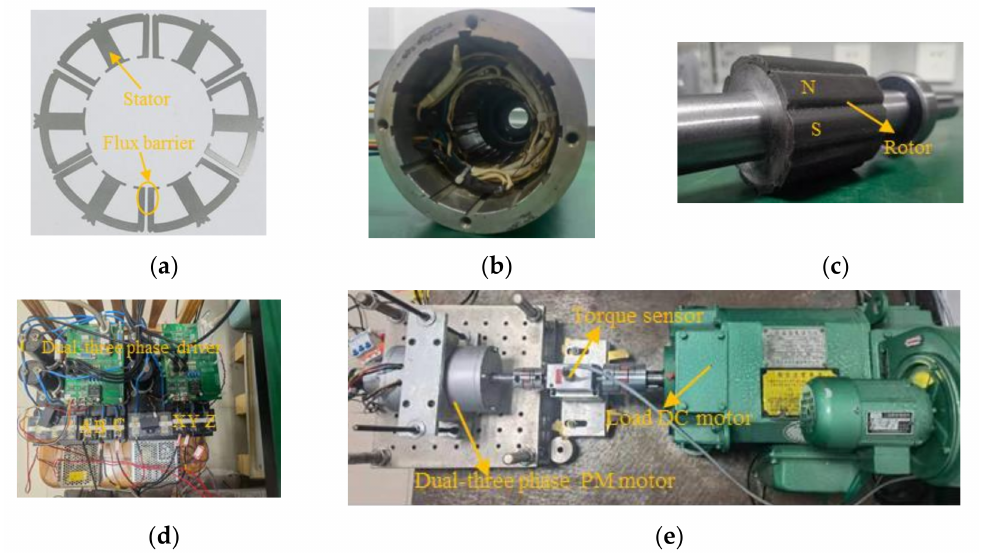
Figure 16. Machine prototype and test rig. ( a ) Stator lamination, ( b ) machine jacket, ( c ) rotor stack with magnets, ( d ) dual three-phase inverter, ( e ) test rig.